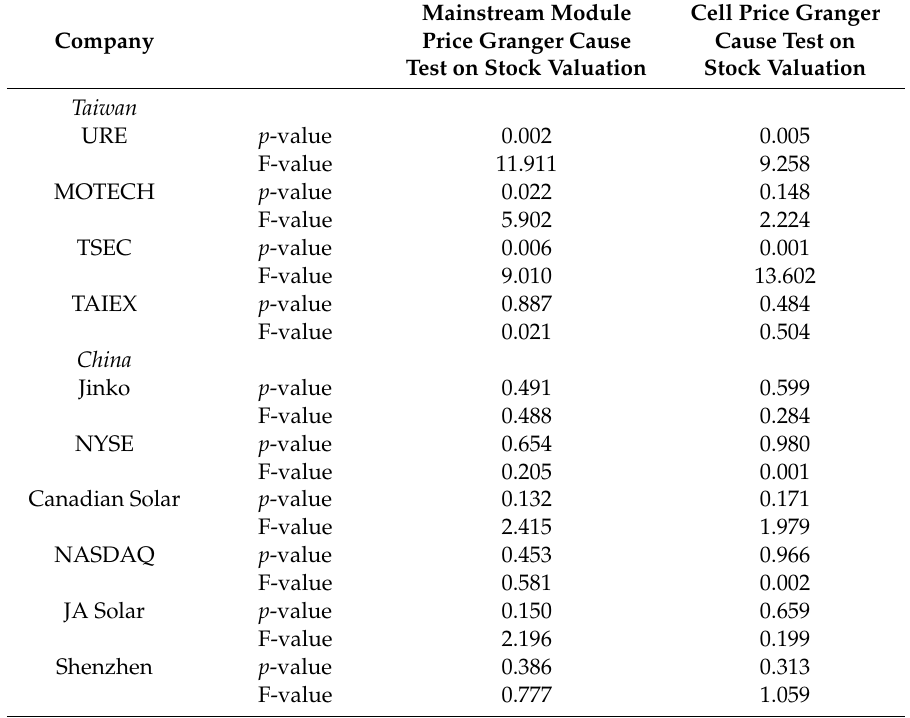
Table 1. Granger causality test of interdependency of the mainstream module and solar cell price on stock valuation of local and Chinese